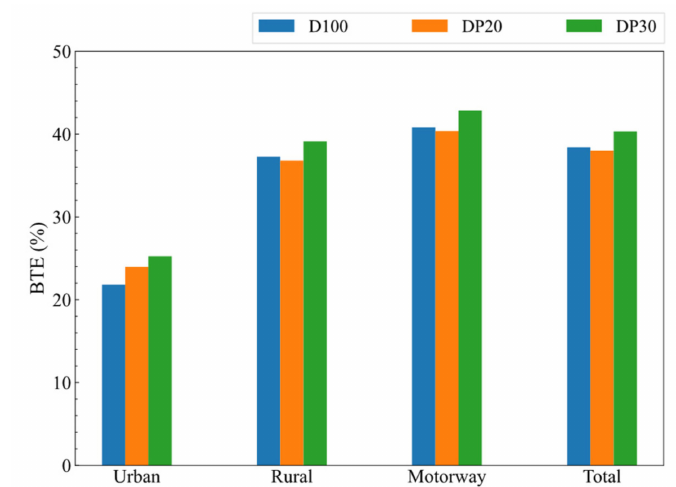
Figure 9. Brake thermal efficiencies under different driving